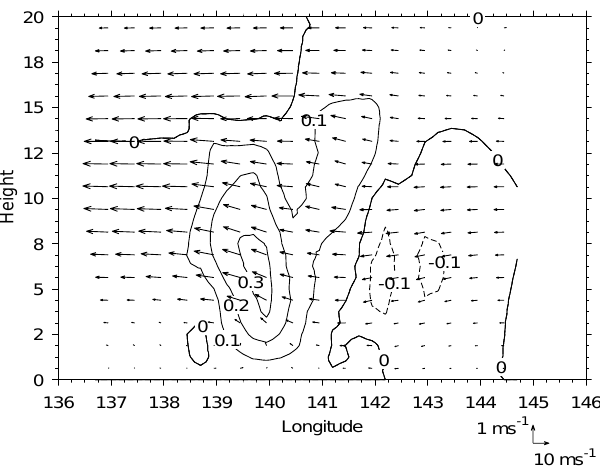
Fig. 11. Same as Fig. 10, but contours show vertical velocity every 0.1 ms − 1